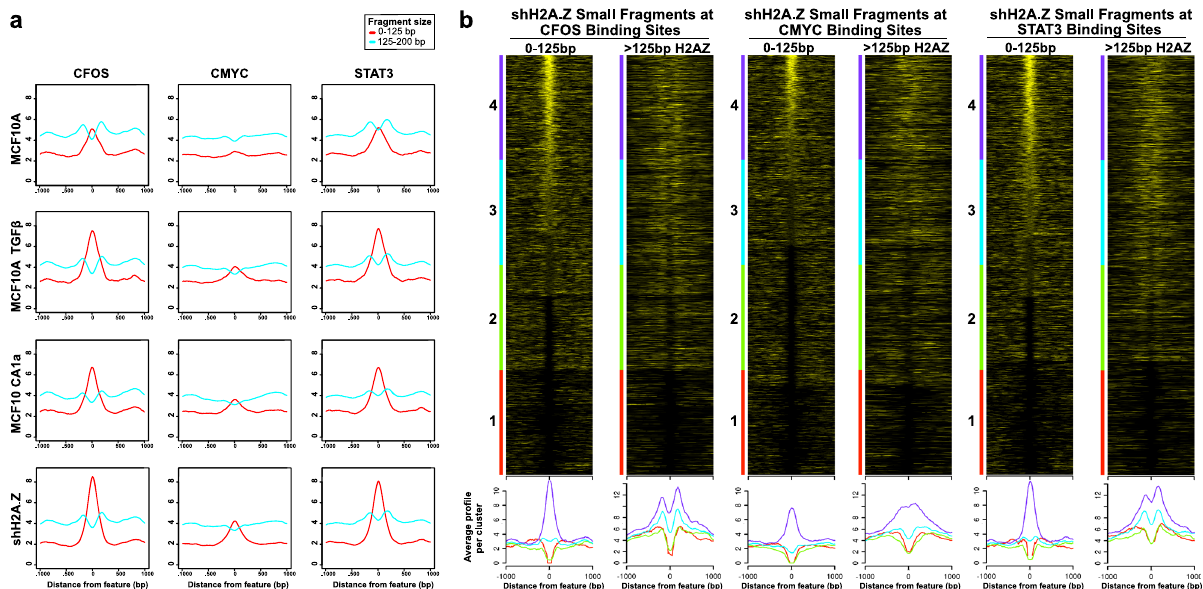
Fig. 6 Mapping of small MNase DNA fragments may serve as a surrogate for transcription factor binding. a Sub-nucleosomal small DNA fragments (<125bp) and nucleosomal-sized DNA fragments (>125 bp) were extracted and aligned to C-Fos, C-Myc and STAT3 transcription factor binding sites for MCF-10A, MCF-10A + TGF- β , MCF-10CA1a and shH2A.ZMCF-10A cells. b Heatmaps, with average pro fi les below, were sorted on maximum occupancy of small DNA fragments (<125bp) ±1 kb centred on the transcription factor binding site. Adjacent to each small DNA fragment heat map are H2A.Z nucleosome heatmaps sorted on the same order. H2A.Z nucleosomes fl ank C-FOS and STAT3 binding sites. transcription factors. Our fi nal aims were to investigate: (1) whether SFs occupy other important promoter DNA elements i.e. c-Fos, c-Myc and STAT3 transcription factor binding sites 49 transcription factor binding sites (TFBS) and (2) if the abundance (Fig. 6a). of these SFs also increase when H2A.Z is depleted. Clear SF peaks are observed at c-Fos and STAT3 binding sites,